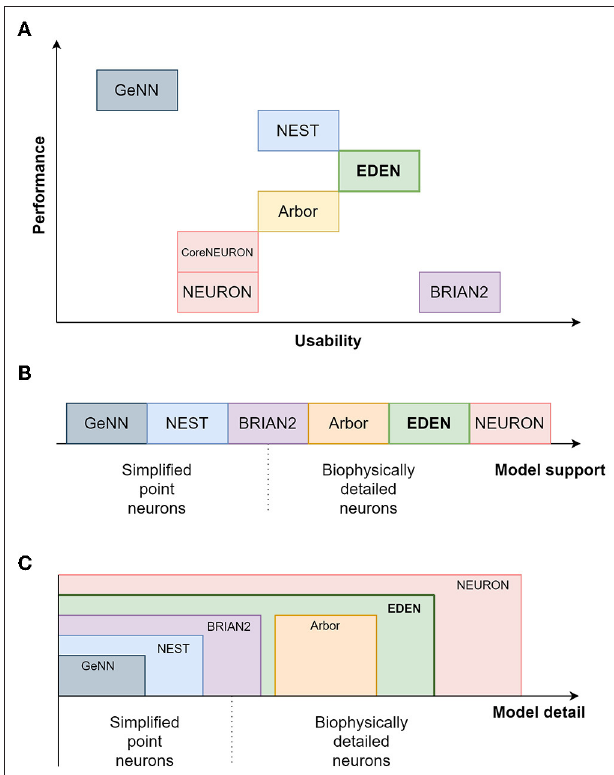
FIGURE 1 | A relative comparison of the characteristics of EDEN and the established neural simulators. (A) compares the simulators on the performance and usability plane; (B) shows the ordering between simulators regarding the level of model detail; and (C) shows the level of modeling detail supported by each